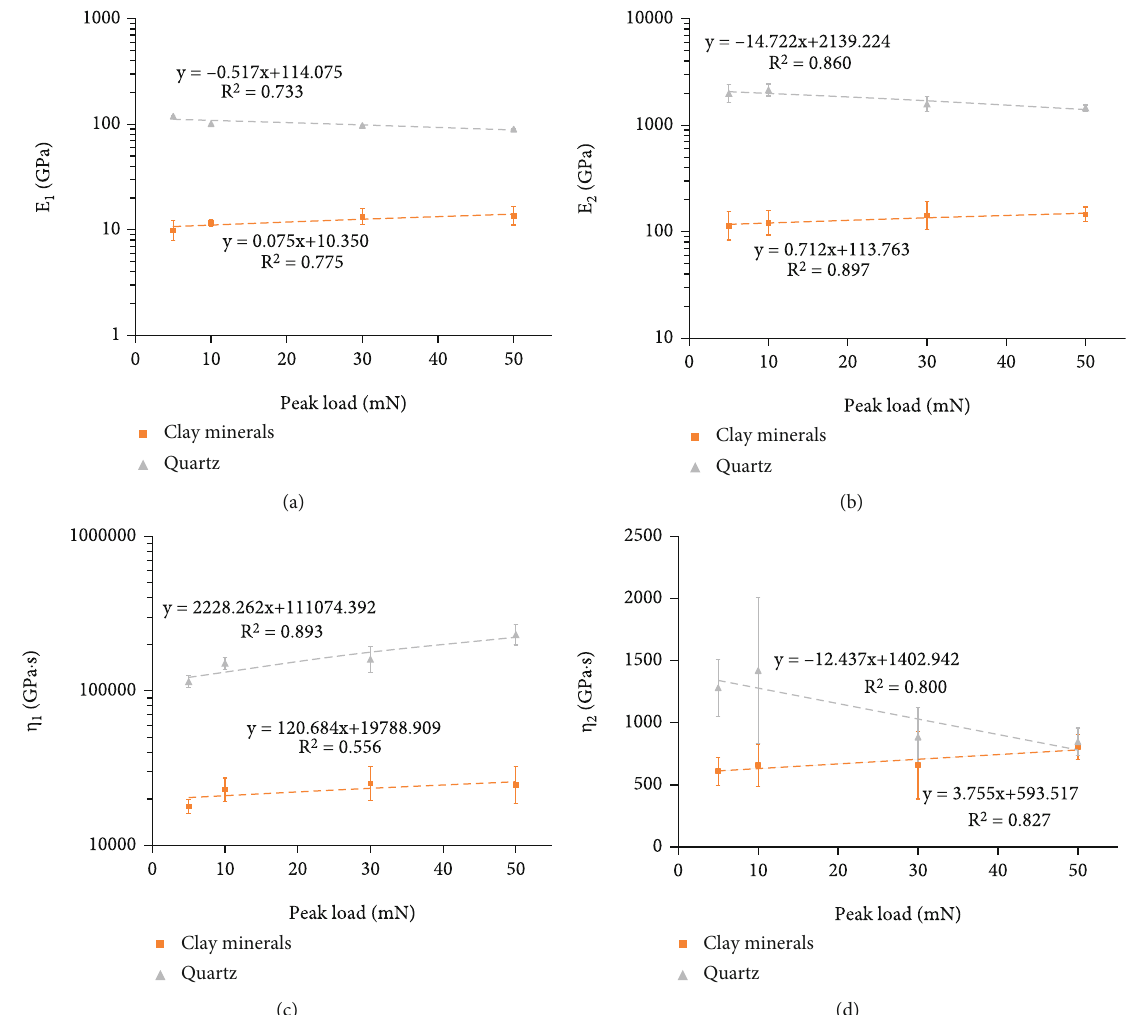
Figure 9: Linear regressions for employing Burger ’ s model for quartz and clay minerals at various peak loads. Fitting parameters: (a) E E , (c) η , and (d) η . Error bars are one standard 2 1 2